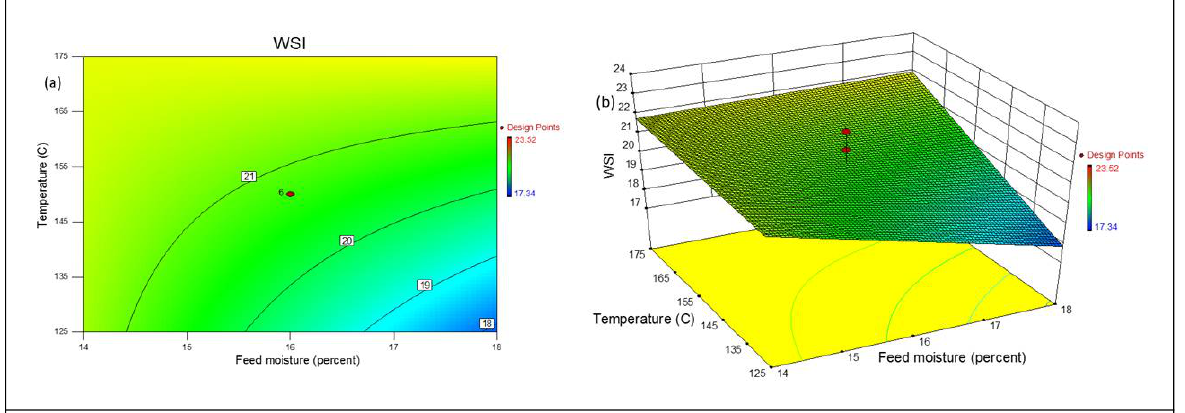
Figure 5: Contour (a) and Response surface (b) plot depicting the behavior of Water Solubility Index (WSI) at different feed moisture and barrel temperature while the other processing variables are at center